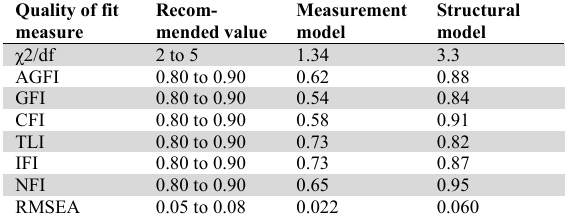
Fit indices for measurement and structural